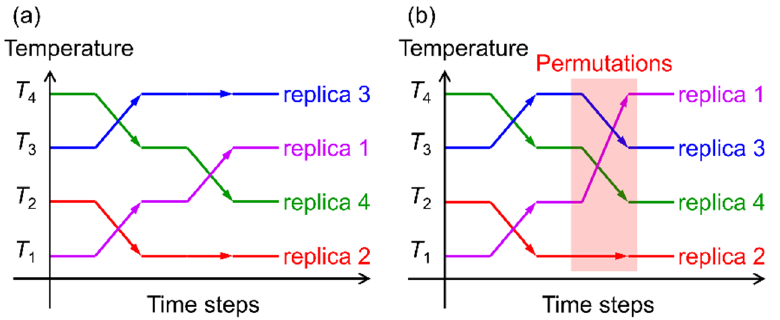
Figure 10. Illustration of the ( a ) replica-exchange method and ( b ) replica-permutation method. In the replica-exchange method, temperatures are exchanged between two replicas, whereas, in the replica-permutation method, temperatures are permuted among three or more replicas.